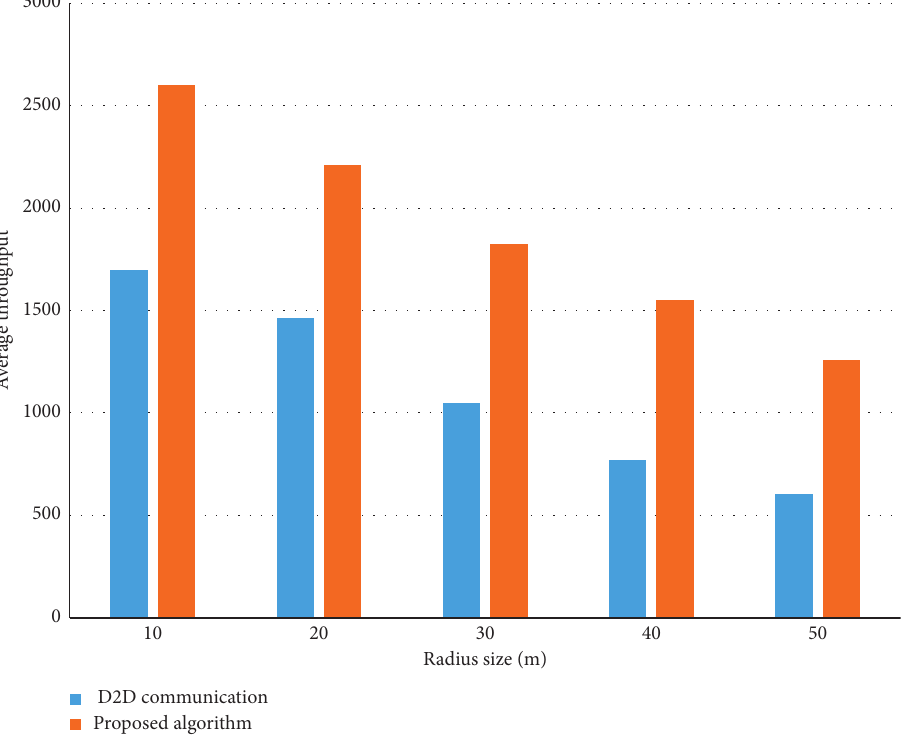
Figure 6: Average throughput against various radius size.